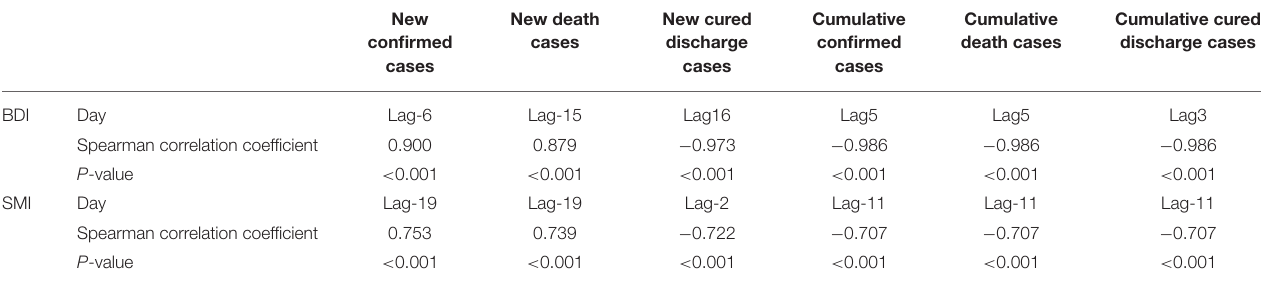
TABLE 1 | The time lag cross-correlation between the BDI, SMI and COVID-19-related data from 20 January to 20 March in 2020.